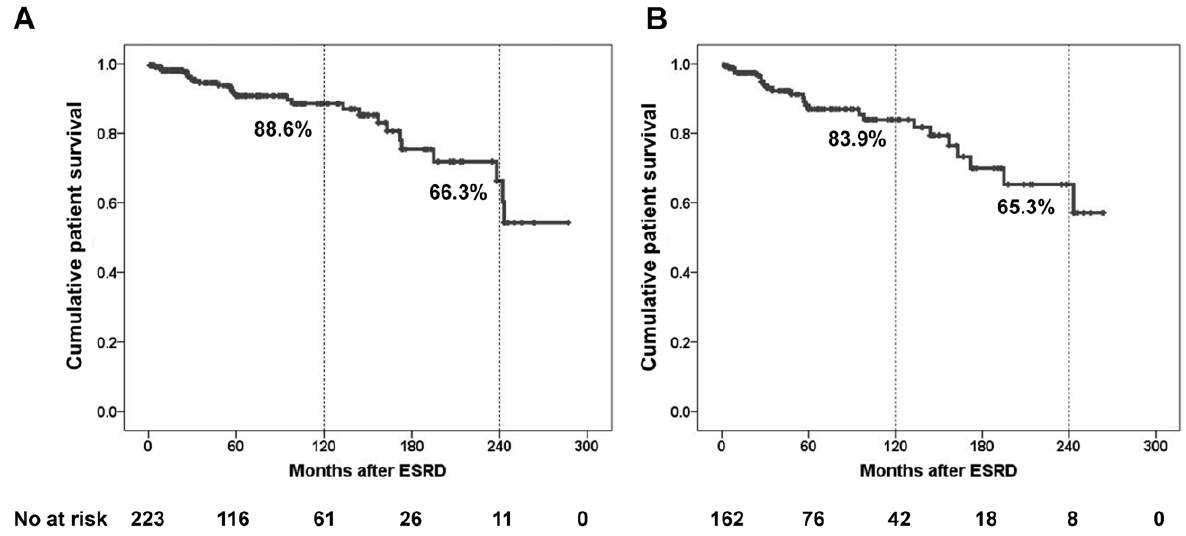
Figure 3. Cumulative patient survival after ESRD progression according to the all ESRD patients ( A ) and excluding transplantation recipients ( B ) . The primary outcome is patient survival. The numbers of patients remaining at 60, 120, 180, 240, 300, and 360 months of follow-up are shown at the bottom. ESRD, end stage renal disease. doi:10.1371/journal.pone.0051225.g003 PLOS ONE |